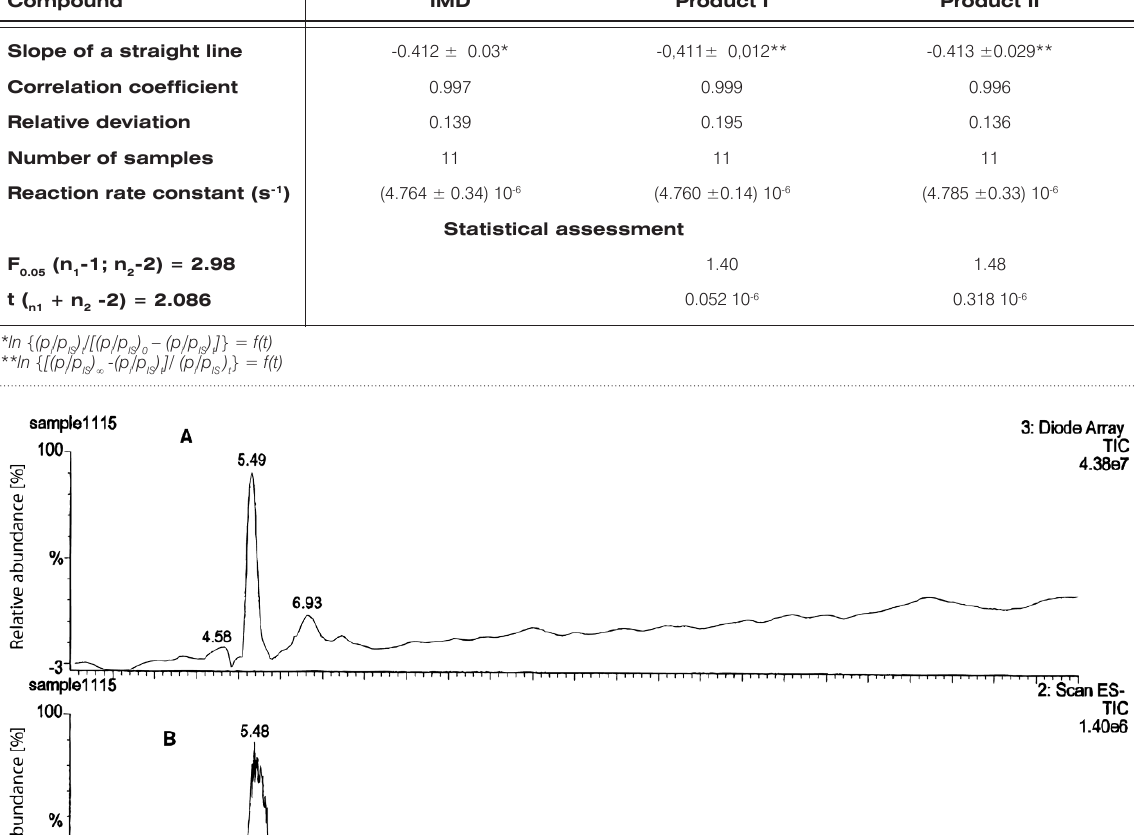
F -Snedecor and Student’s t -tests (Table 3) and since